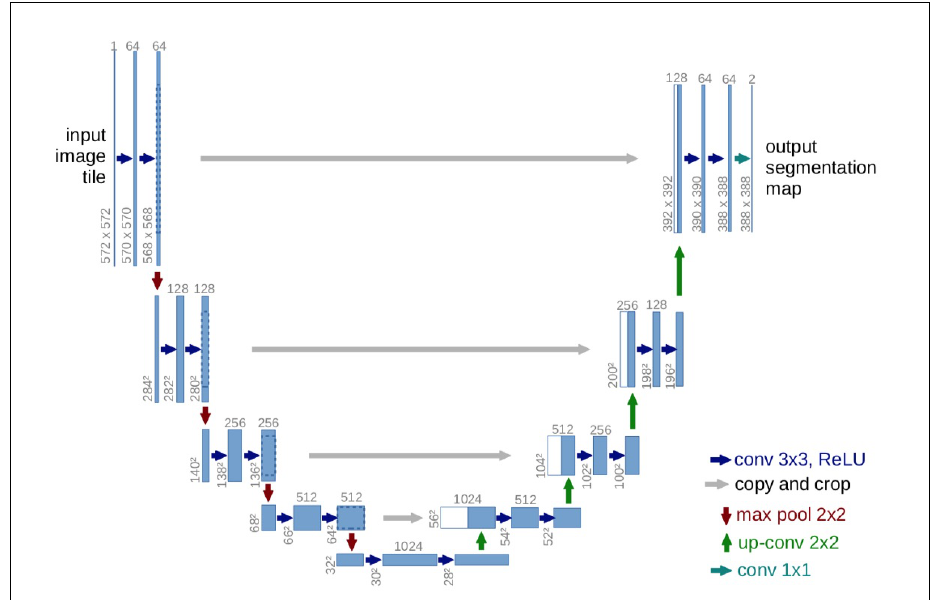
Figure 8. Diagram demonstrating the construction of the U-Net neural network